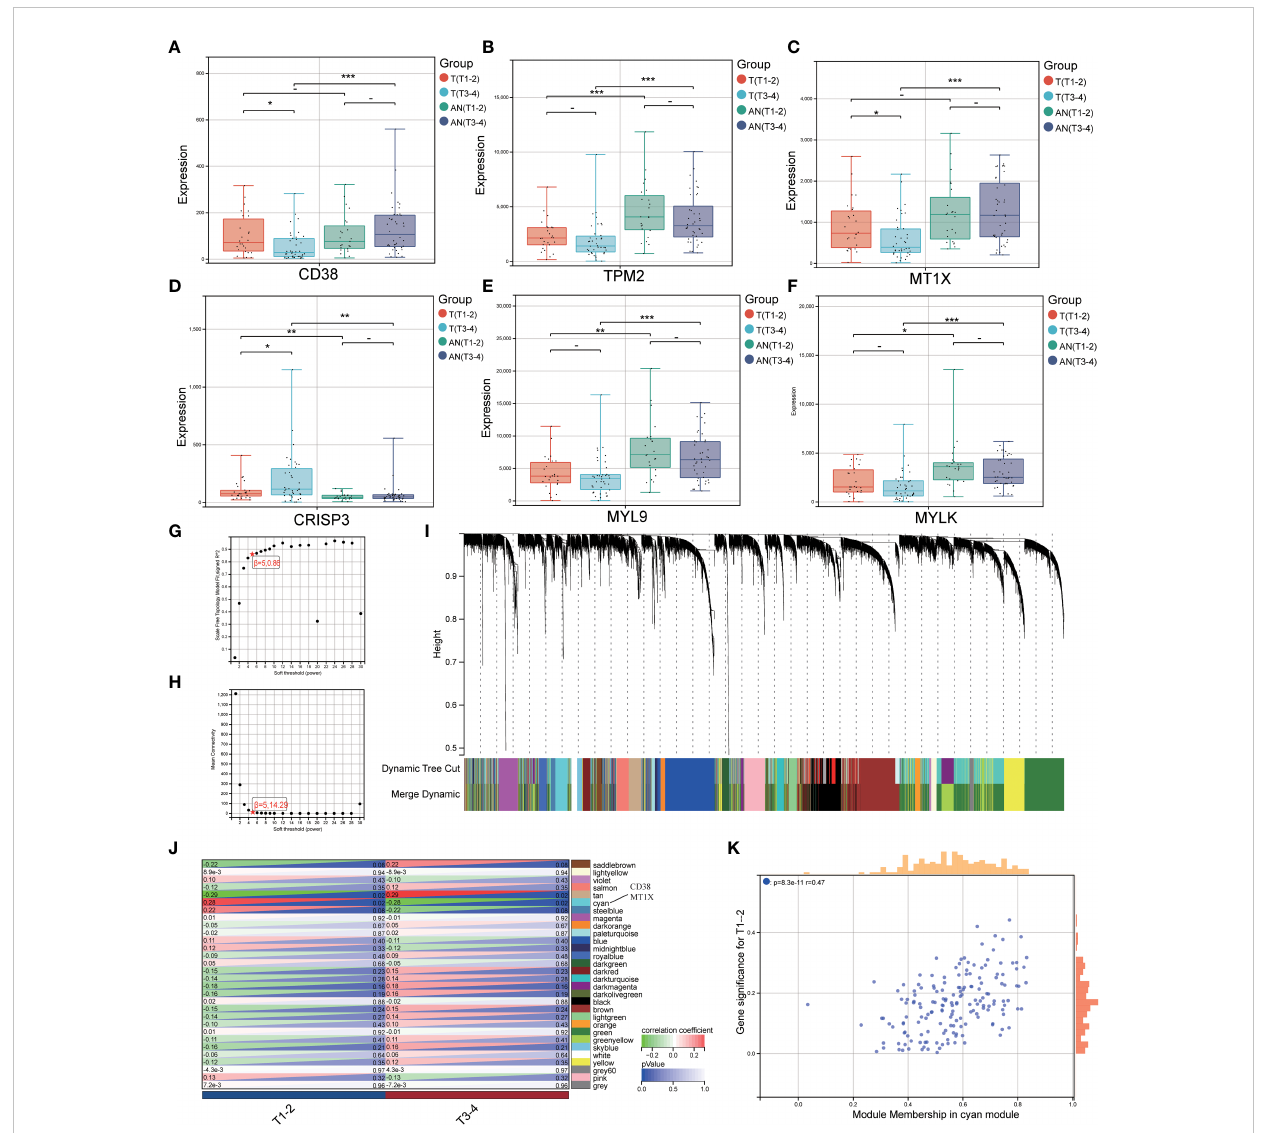
FIGURE 4 LRHG and tumor invasion phenotype. (A – F) . Expression of CD38 , TPM2 , MT1X , CRISP3 , MYL9 , and MYLK in non-invasive (T1-2) and invasive (T3-4) tissues; (G, H) . Scale-free fi tting Index and average Connectivity Analysis of different soft threshold Power ( b ); (I) . The clustering tree diagram of the recognition module. Each module is given a separate color as a logo, including 30 different modules; (J) The heat map of module-characteristic relationship and cyan module were signi fi cantly correlated with prostate cancer invasion; (K) The scatter diagram of the correlation between the number of gene module members and gene signi fi cance in the cyan module. * P < 0.05; * * P < 0.01; *** P < 0.001. -: no relevant